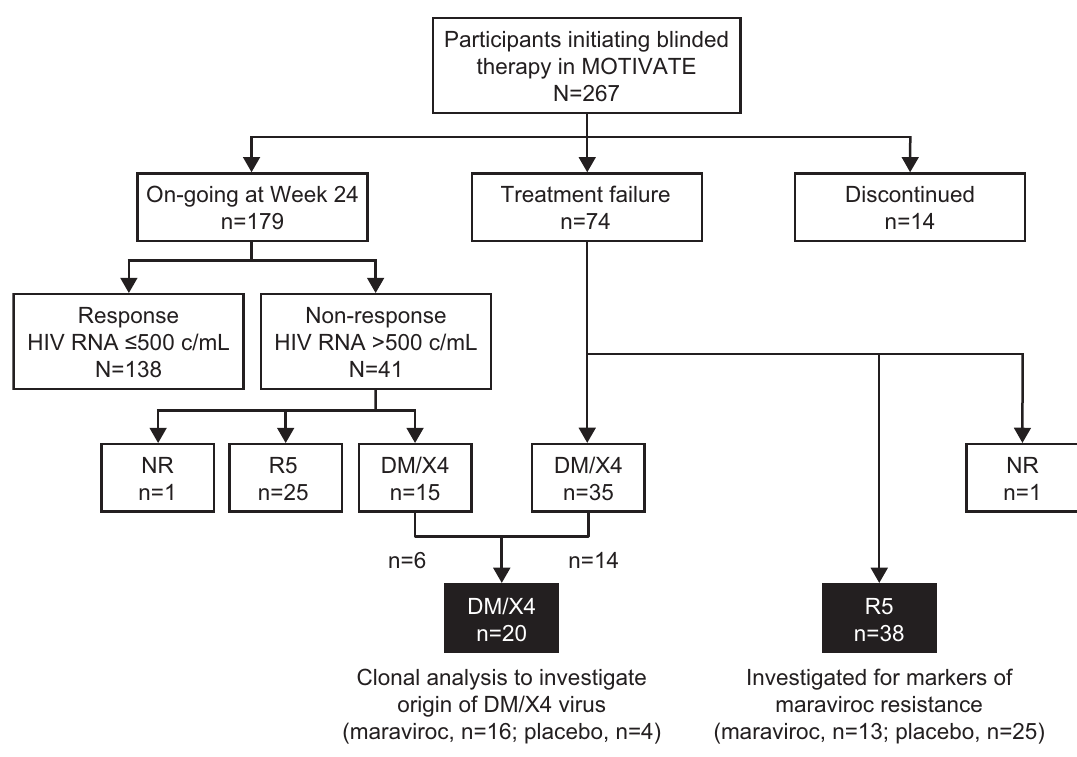
Fig 1. Characterization of participants from MOTIVATE 1 and 2 for analysis of mechanisms of virologic failure.